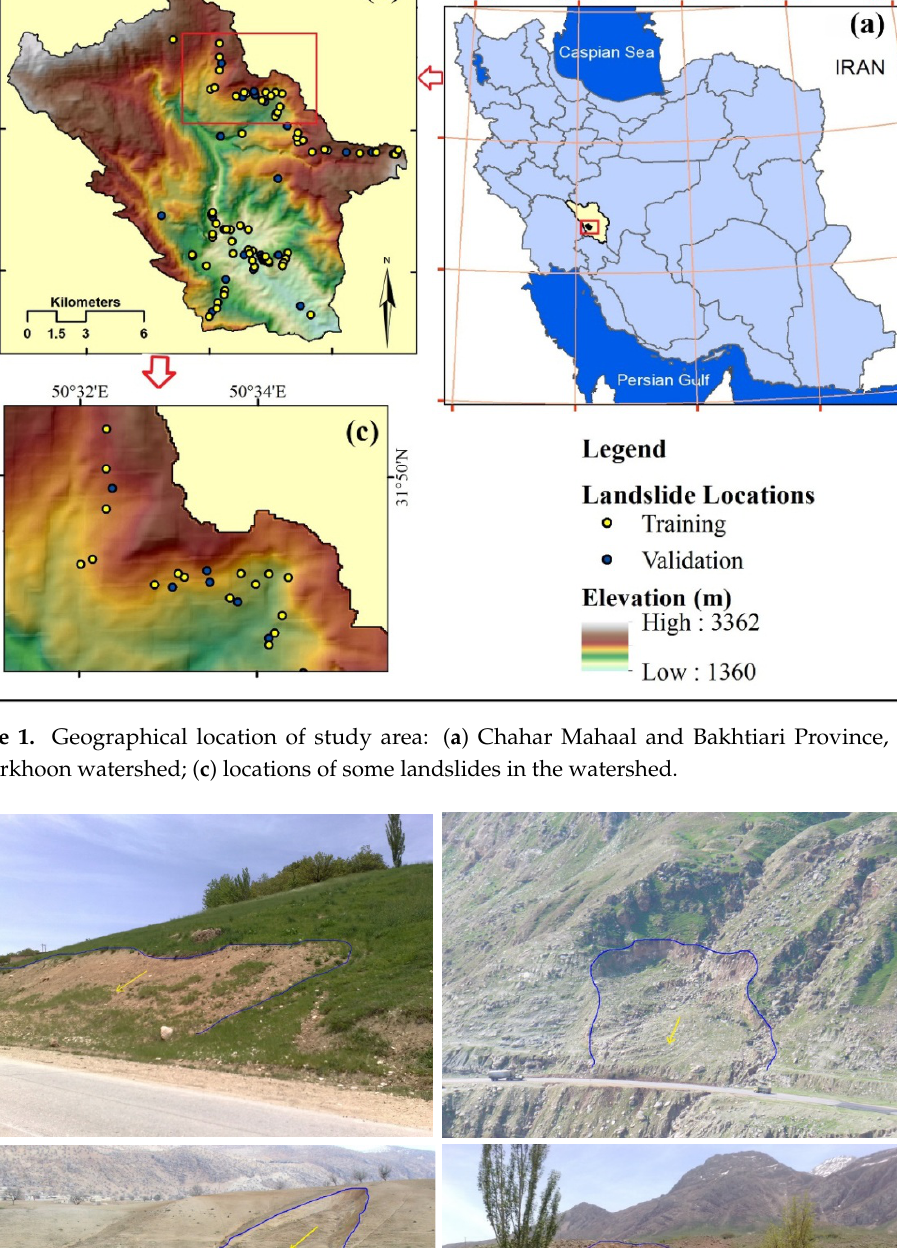
Forests 2019 , 10 , x FOR PEER REVIEW Table 1. Geological units in the study area [58].